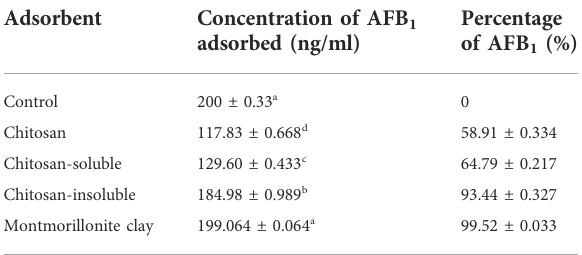
TABLE 3 Concentration of AFB 1 adsorbed for chitosan, chitosan- soluble, chitosan-insoluble, and montmorillonite clay in an in vitro gastrointestinal poultry model.